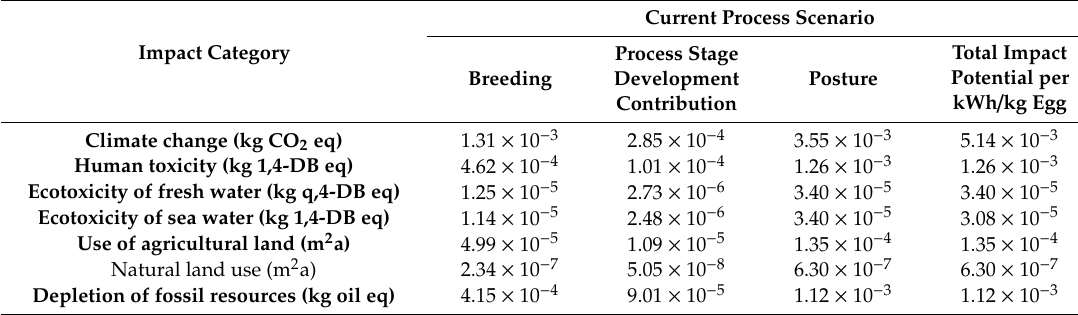
Table 6. Potential impacts of egg production related to the use of process electricity.